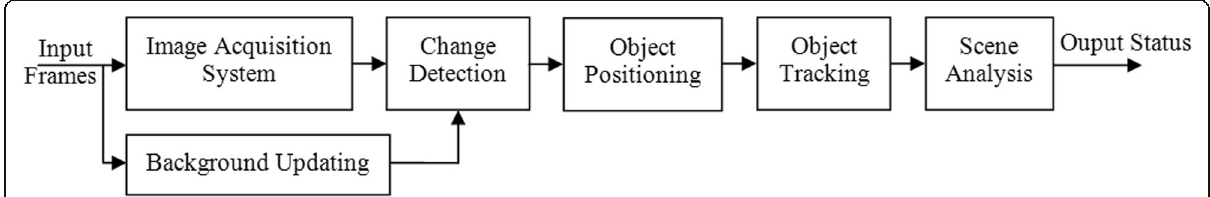
Fig. 2 Details block diagram of spatial-temporal segmentation